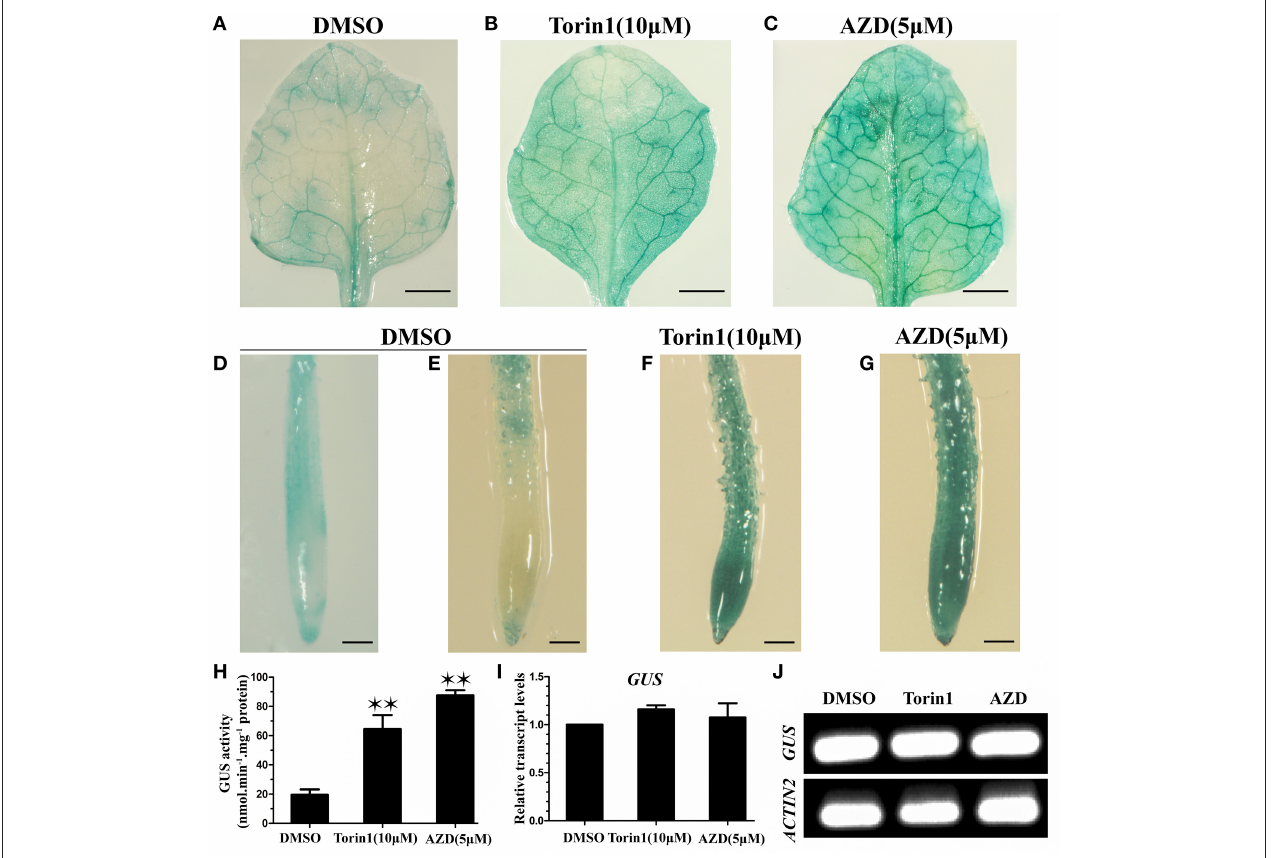
FIGURE 6 | Suppression of TOR results in the accumulation of TRIN1 protein in Arabidopsis . (A–G) GUS staining of the first true leaves of P35S::TRIN1-GUS OE-2 plants. (A–C) GUS staining of leaves of 2-week-old P35S::TRIN1-GUS plants treated with DMSO, Torin1, and AZD for 48h. Bar = 1mm. (D) GUS staining of root tips of 2-week-old P35S::GUS plants treated with DMSO for 48h. (E–G) GUS staining of root tips of 2-week-old P35S::TRIN1-GUS plants treated with DMSO, Torin1, and AZD for 48h. Bar = 0.1mm. (H) GUS activity of the first true leaves of 2-week-old P35S::TRIN1-GUS plants was measured by fluorometric quantification, plants were treated as described in (A–C) . Asterisks denote Student’s t -test significant difference compared with DMSO ( ** P < 0.01 ). (I) qRT-PCR analysis of GUS relative transcript level of 2-week-old PTRIN1::GUS plants treated with DMSO, AZD (5 µ M) and Torin1 (10 µ M) for 48h. The data represent the mean ± SD of n =